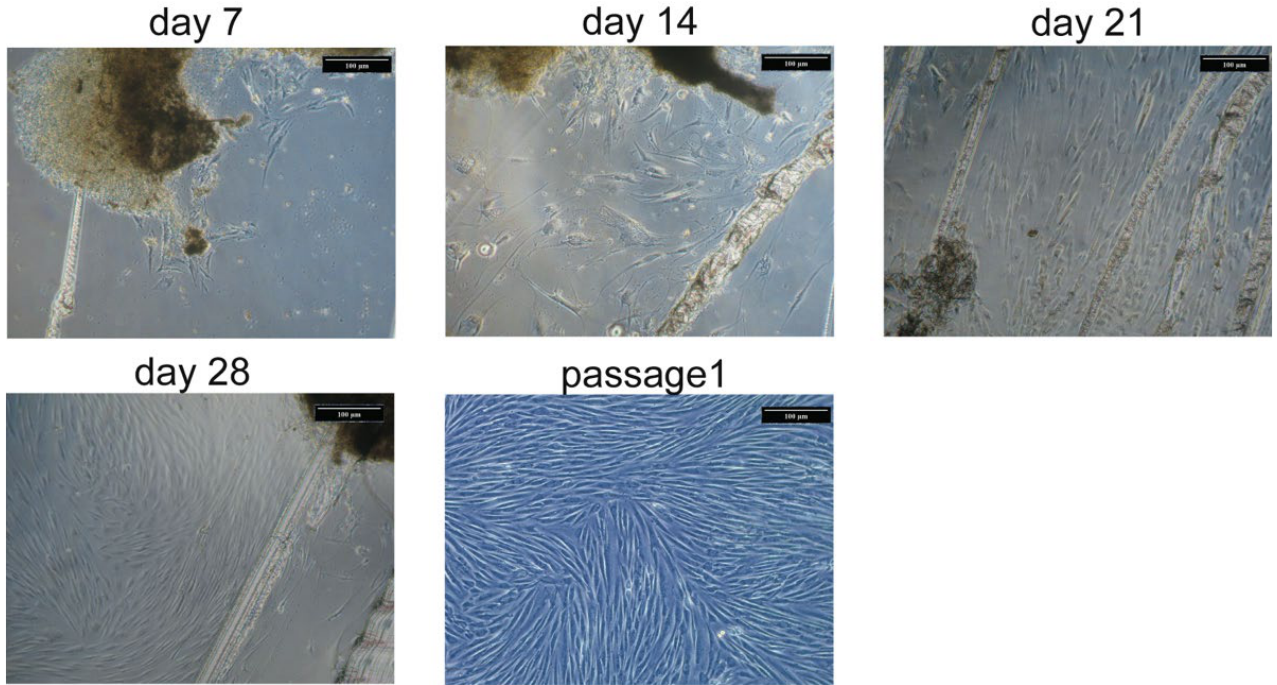
Figure 2. Representative photos of cell isolation from bone explants. Scrapes on the culture flask surface help to fix bone pieces. First cells were observed at 3–7 days of isolation. It takes 4–5 weeks before cells reach confluence and could be passaged. After passaging cell culture becomes more homogenous.